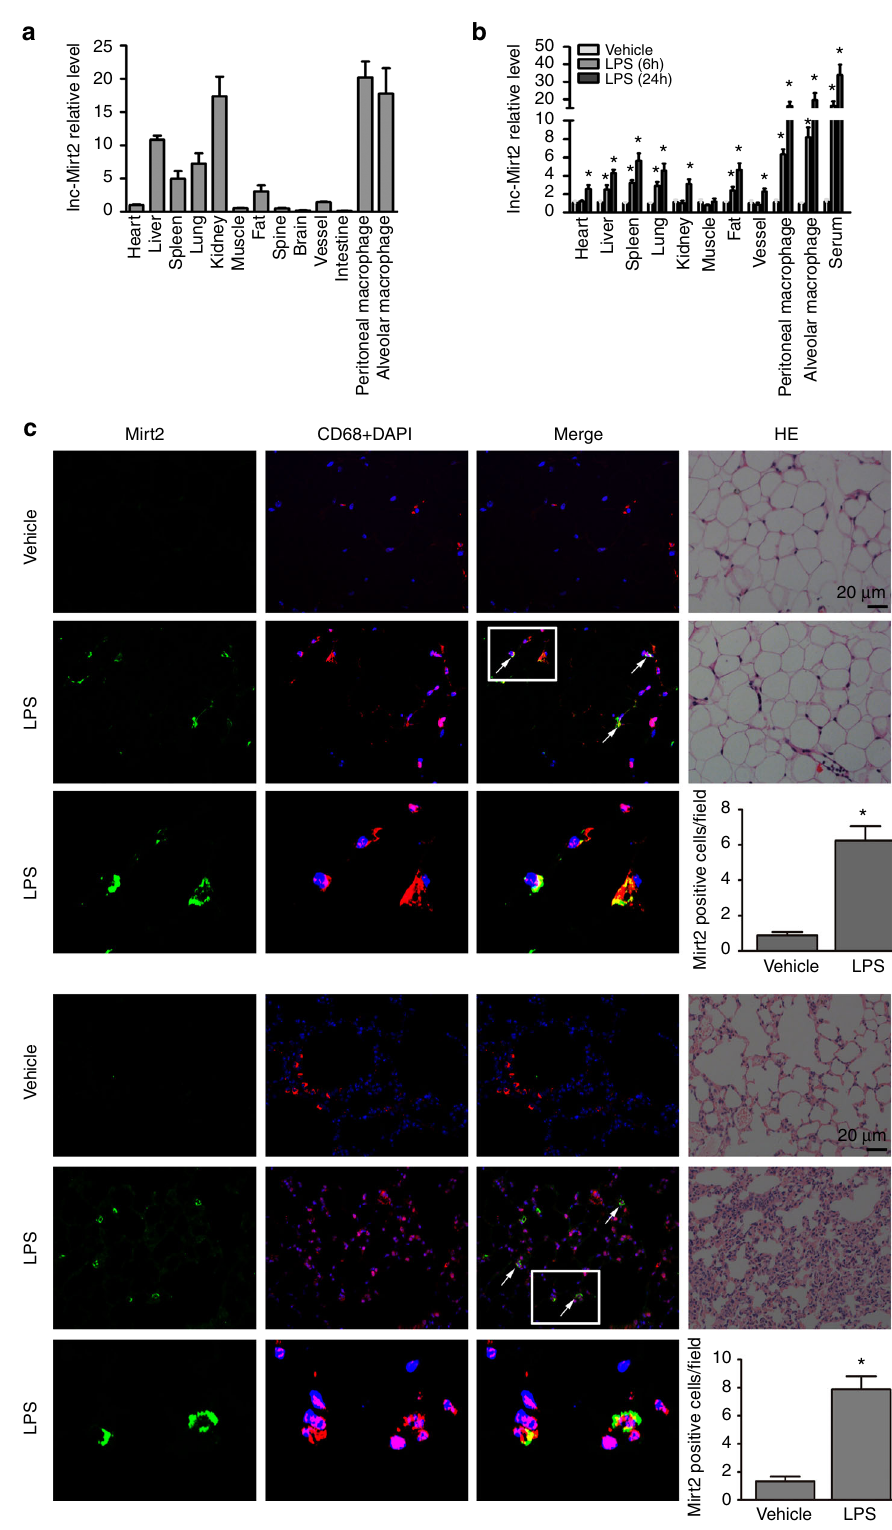
Fig. 2 Mirt2 expression is induced in mice with endotoxemia. a Expression and distribution of Mirt2 in C57BL/6 mice. b Expression of Mirt2 in various tissues of endotoxemia mice challenged with LPS (25 mg/kg) for 6 and 24 h. c RNA FISH analysis of Mirt2 in adipose tissue (upper) and lung (lower) from normal or mice with endotoxemia. For colocalization analysis, sections were co-stained for Mirt2 (green) and CD68 (red, macrophage marker). DAPI was used for nucleus staining (blue). Arrows indicate Mirt2 and CD68 double positive cells. Double positive cells were counted in four sections per mouse and quanti fi ed. Data are expressed as mean ± SEM (n = 6). * P < 0.05 vs. control group Two-tailed Student ’ s t test for two